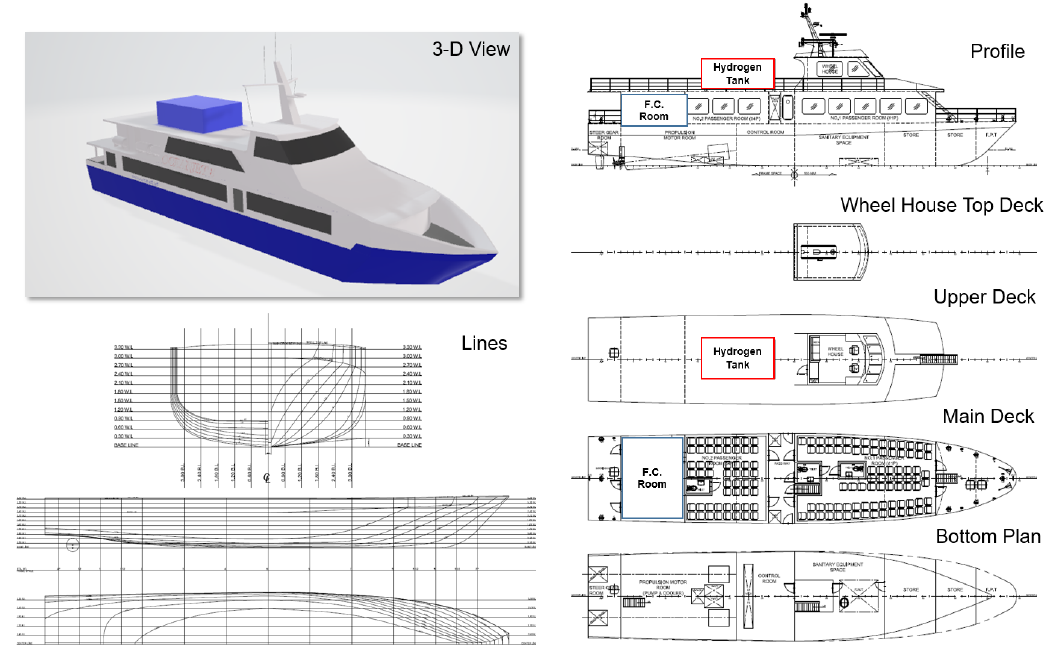
Figure 12. The 3D view, lines, and general arrangement of the 170 GT nearshore